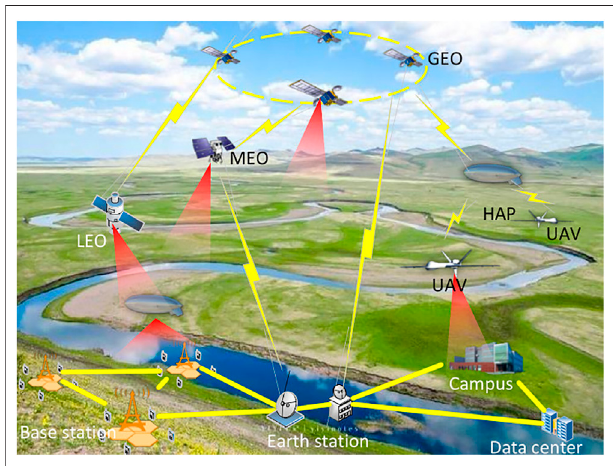
FIGURE 1 | Typical scenarios of heterogeneous network interconnection and integration based on space, air, and ground networks.